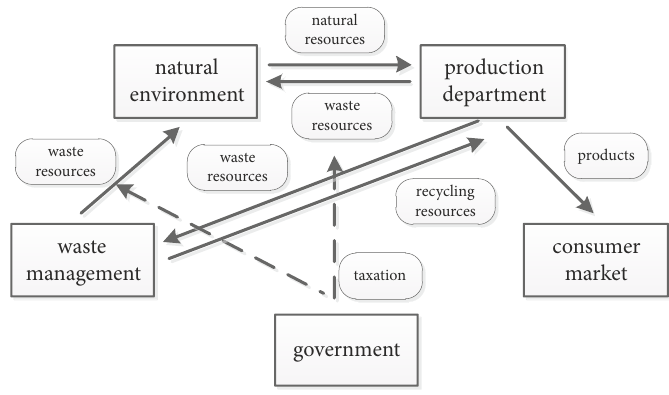
Figure 7. Pollution tax model with recycling resource